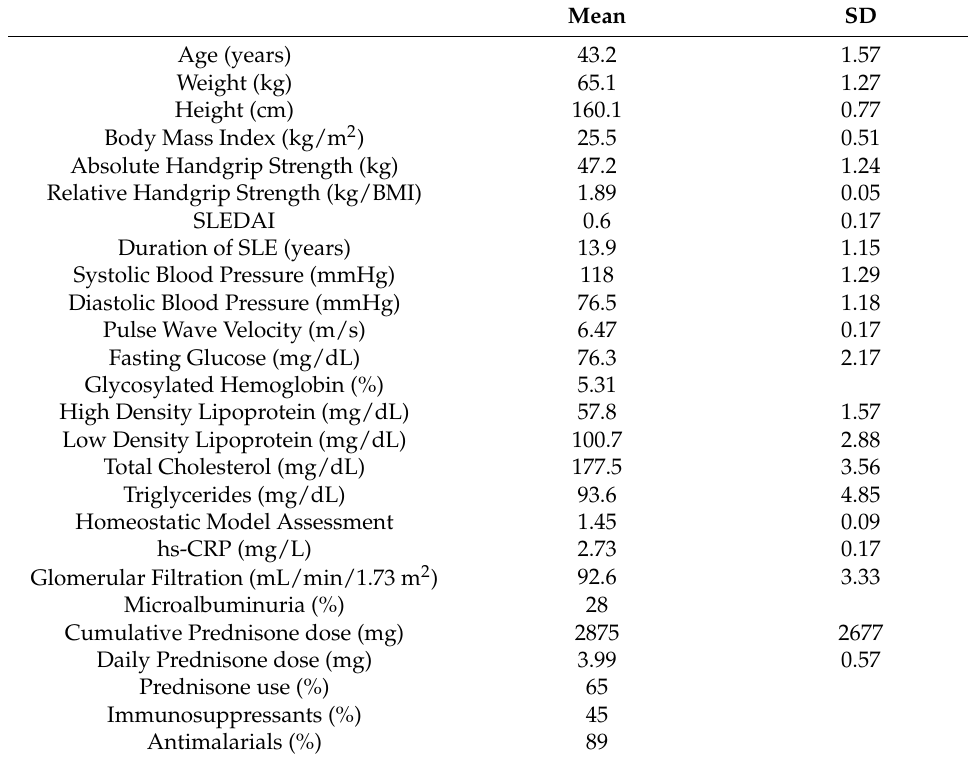
Table 1. Descriptive characteristics of the study participants ( n =